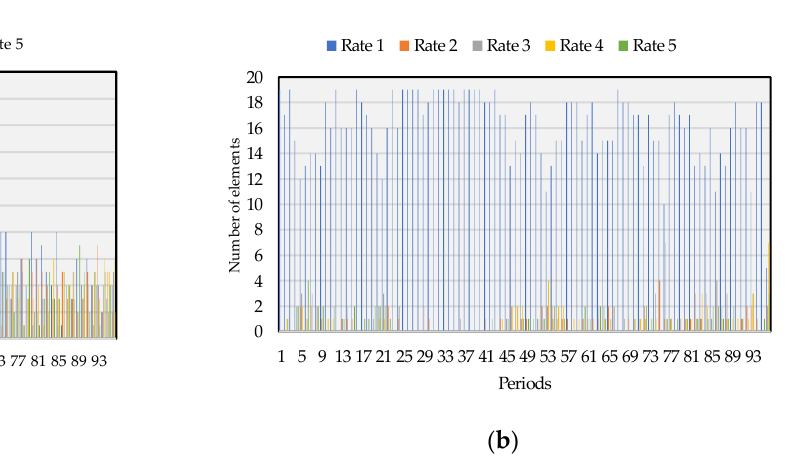
Figure 8. CTR from ( a ) prosumers’ load flexibility per period and ( b ) prosumers’ BES discharging.